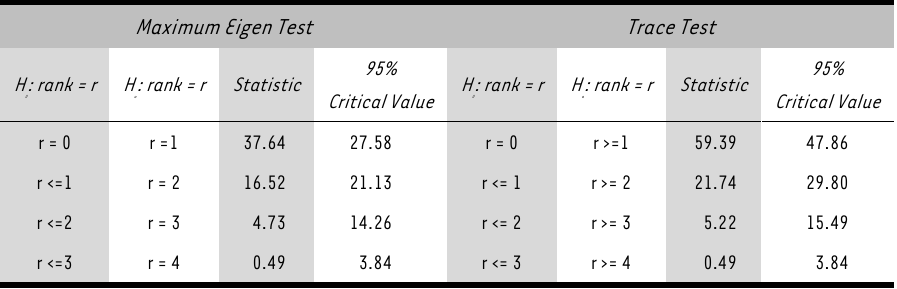
Johansen Cointegration Test Based on Trace and Maximum Eigen Values of the Stochastic Matrix for the exchange rate pass-through model Maximum Eigen Test Trace